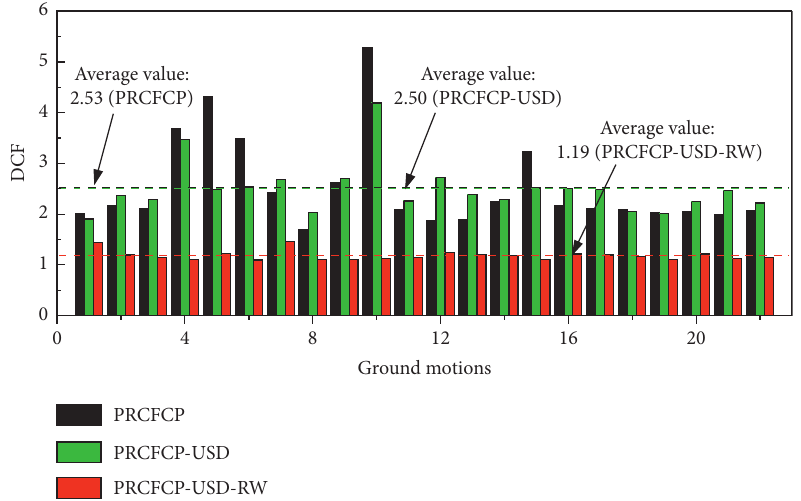
Figure 11: Comparison of the DCF s under major earthquakes.